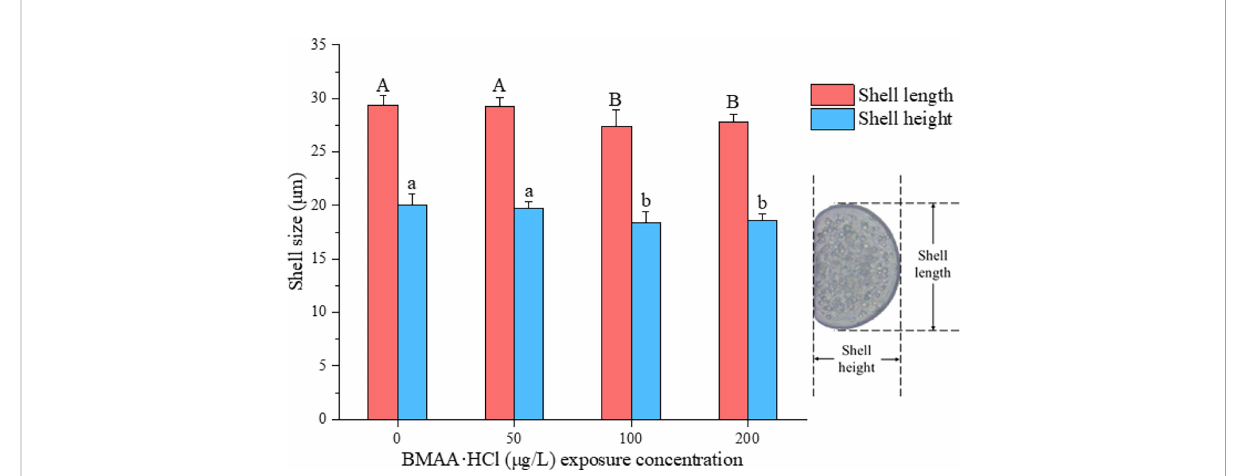
FIGURE 3 Shell size of normal D-veligers at 48 HPF in the mussel ( Mytilus galloprovincialis ) embryos following exposure to BMAA. Note: An equivalent volume of 2 mmol/L HCl used in the highest BMAA exposure treatments was added into the culture wells as a solvent control group and labeled as a zero concentration of BMAA. The different letters indicate a signi fi cantly different result between treatments ( p <